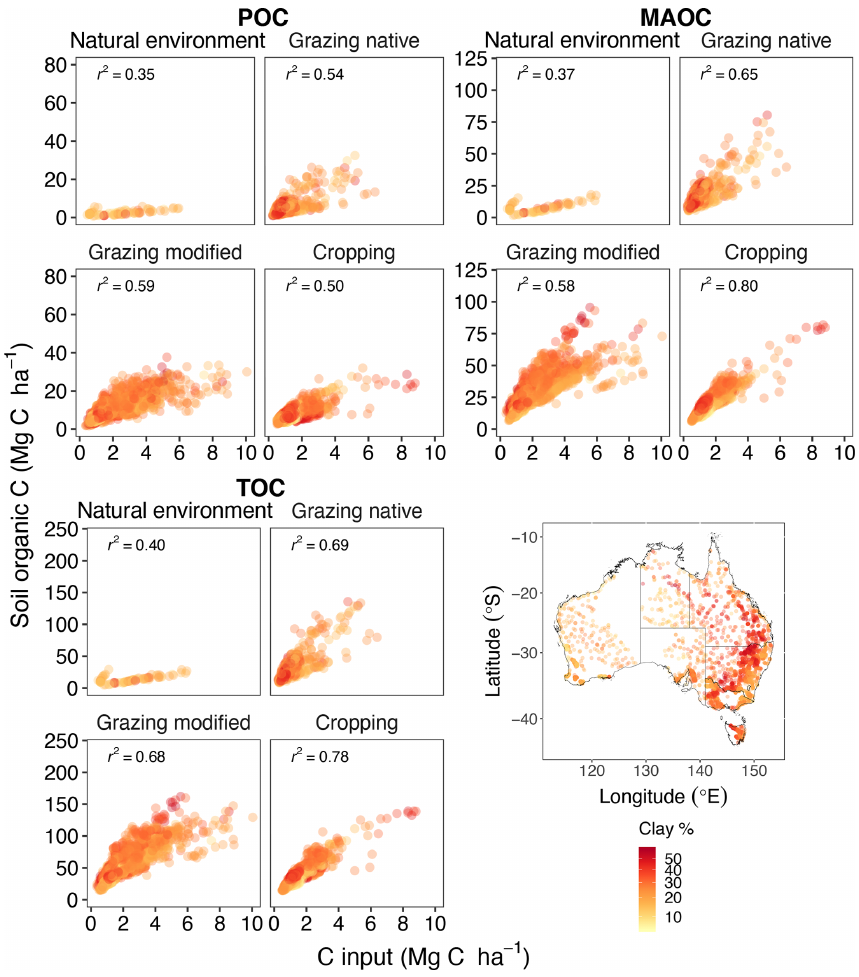
Figure 4. Changes in total, particulate and mineral-associated organic C (TOC, POC and MAOC) with C inputs by land use ( n = 4043).